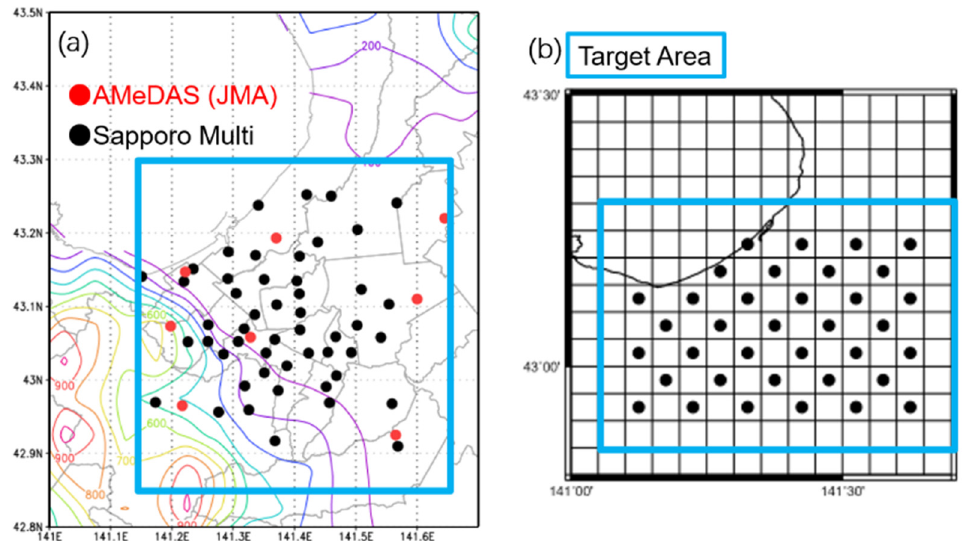
Figure 3. ( a ) Distribution of precipitation station by AMeDAS (red) and Sapporo Multi (black) within the target area (a light-blue rectangle). The colored contours in the left panel indicate elevation (orography); ( b ) daily precipitation at the 36-grid points in the target area (a light-blue rectangle) was the subject of EOF analysis in this study.